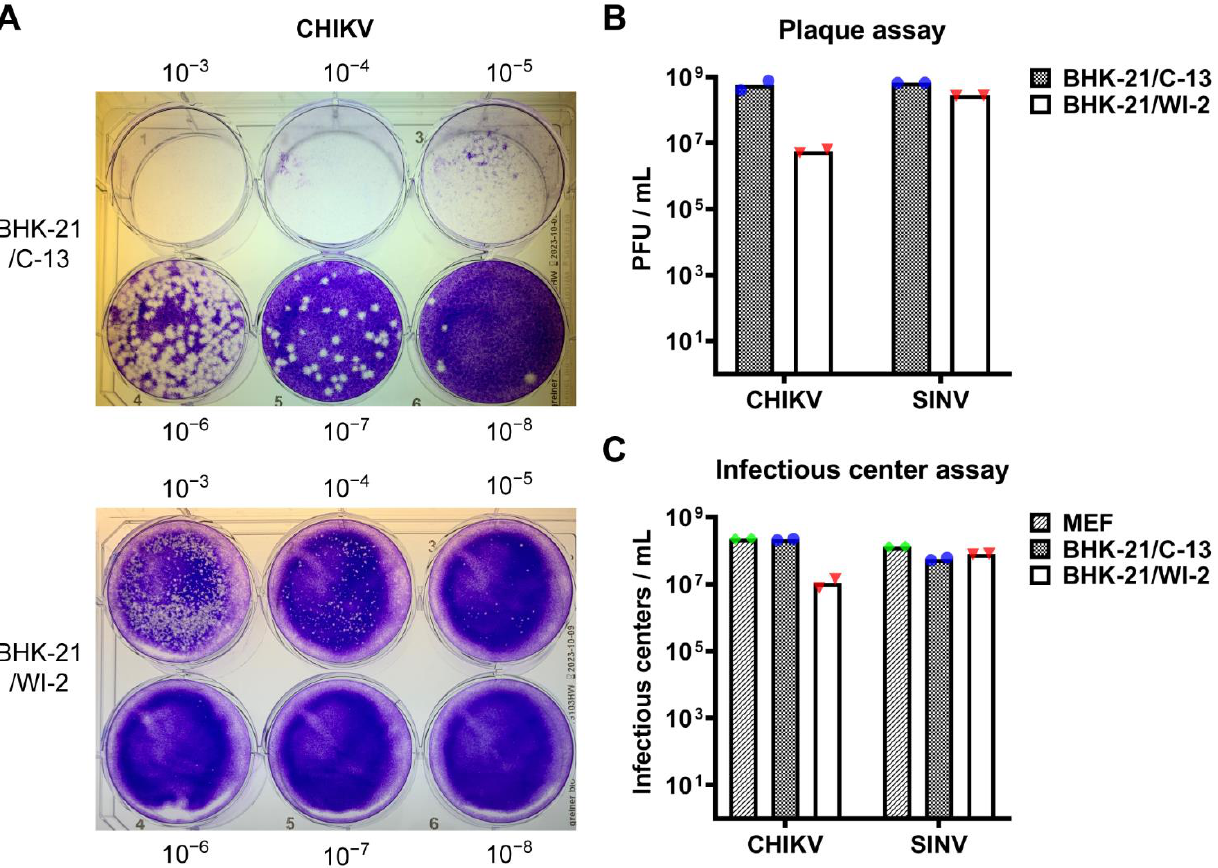
Figure 1. Infectivity of CHIKV in BHK-21/C-13 and BHK-21/WI-2 cells. ( A , B ) BHK-21/C-13 cells or BHK-21/WI-2 cells were infected in parallel with serial dilutions of CHIKV or SINV and overlaid with medium containing 0.5% CMC. Plaques were fixed and stained at 48 h post-infection. Representative images from one of 2 independent experiments are shown in ( A ). The bar graph in ( B ) shows the mean and individual data points of 2 independent experiments. ( C ) Infectious center assay. MEF, BHK-21/C-13, or BHK-21/WI-2 cells were infected in parallel with serial dilutions of CHIKV or SINV. Primary infection was quantitated by immunofluorescence. Data shown are the mean and individual data points of 2 independent